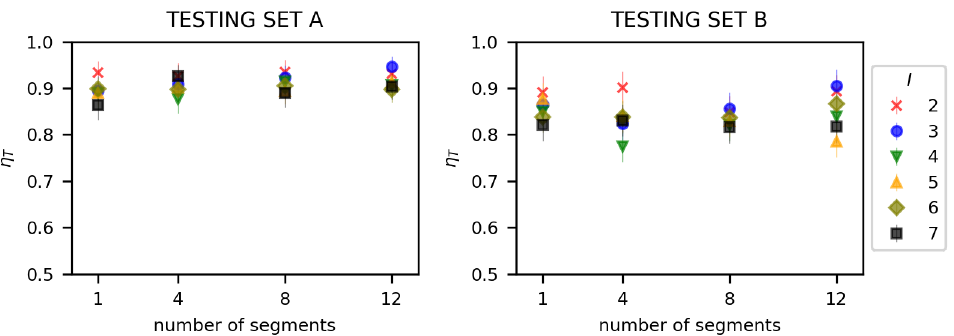
Figure 17. Number of segments impact on selection efficiency for Dataset A and Dataset B—SDL-LEM.